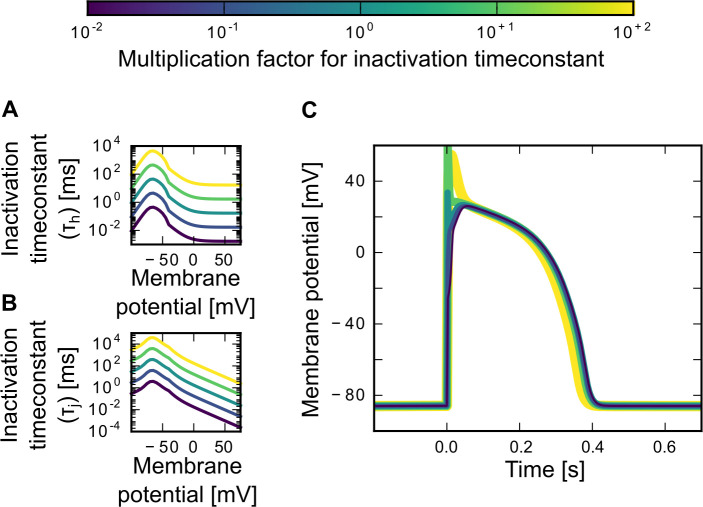
Changing the sodium channel activation time-constant τh
and τj.(A,B) Different multiplication factors (from 10−2 to 10+2) result in different time-constants for the sodium inactivation gates h (A) and j (B). (C) The different inactivation time-constants give rise to different shapes of the cardiac action potential. The colors match the corresponding inactivation curves in A and B. The plot shows one action potential triggered by a 2 ms stimulation pulse of 60 pA/pF amplitude. The system was given 1 s to settle onto the resting potential before the pulse started at timepoint zero.